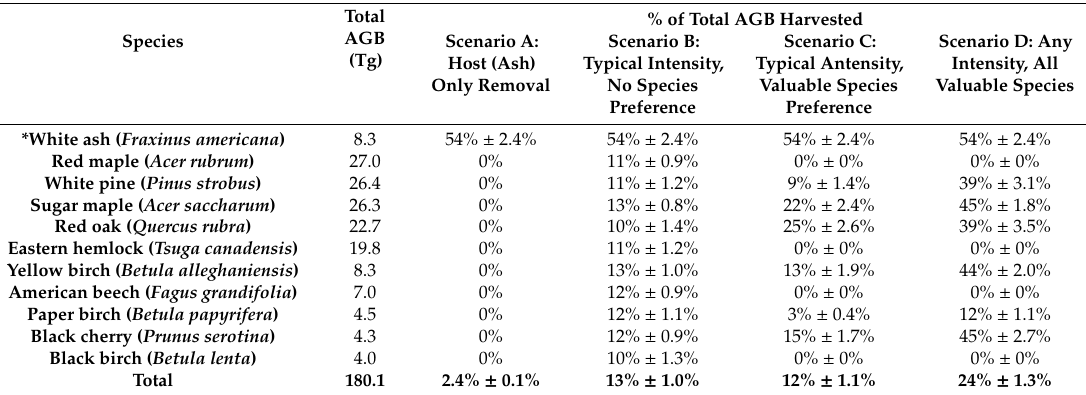
Table 2. Merchantable timber aboveground biomass (AGB) of the 10 most abundant species and the most abundant ash species* in harvestable FFO parcels in the Connecticut River Watershed and the % harvested in response to EAB for each scenario. Total % of Total AGB Harvested AGB Species Scenario A: Scenario B: Scenario C: Scenario D: Any (Tg) Host (Ash) Typical Intensity, Typical Antensity, Intensity, All Only Removal No Species Valuable Species Valuable Species Preference Preference * White ash ( Fraxinus americana